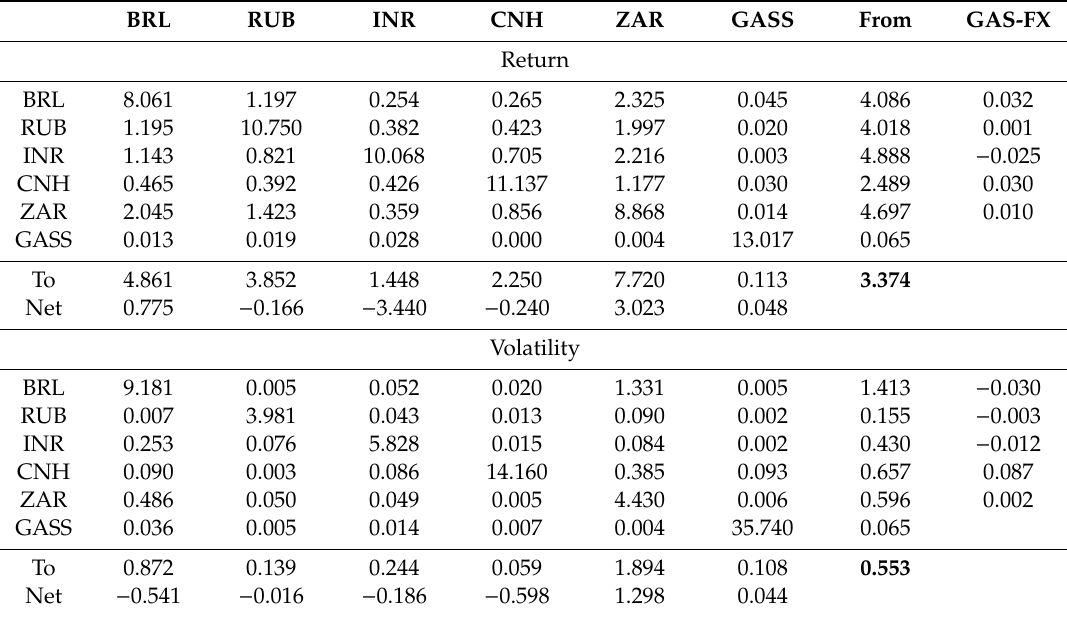
Table A4. Connectedness between the natural gas spot price and exchange rates in the frequency domain (medium